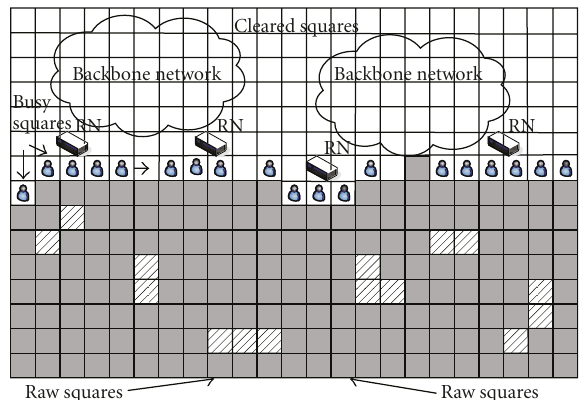
Figure 2: A realistic scenario of DAWN in the middle of the disaster area relief process. The squares with head portraits denote busy squares. White squares denote cleared squares. Dark squares denote disaster area yet to clear. Stripe squares represent unreachable spots within the disaster